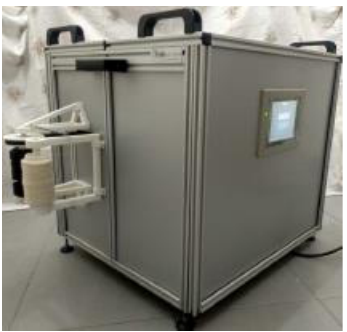
Figure 26. Textile yarn winding and unwinding machine.